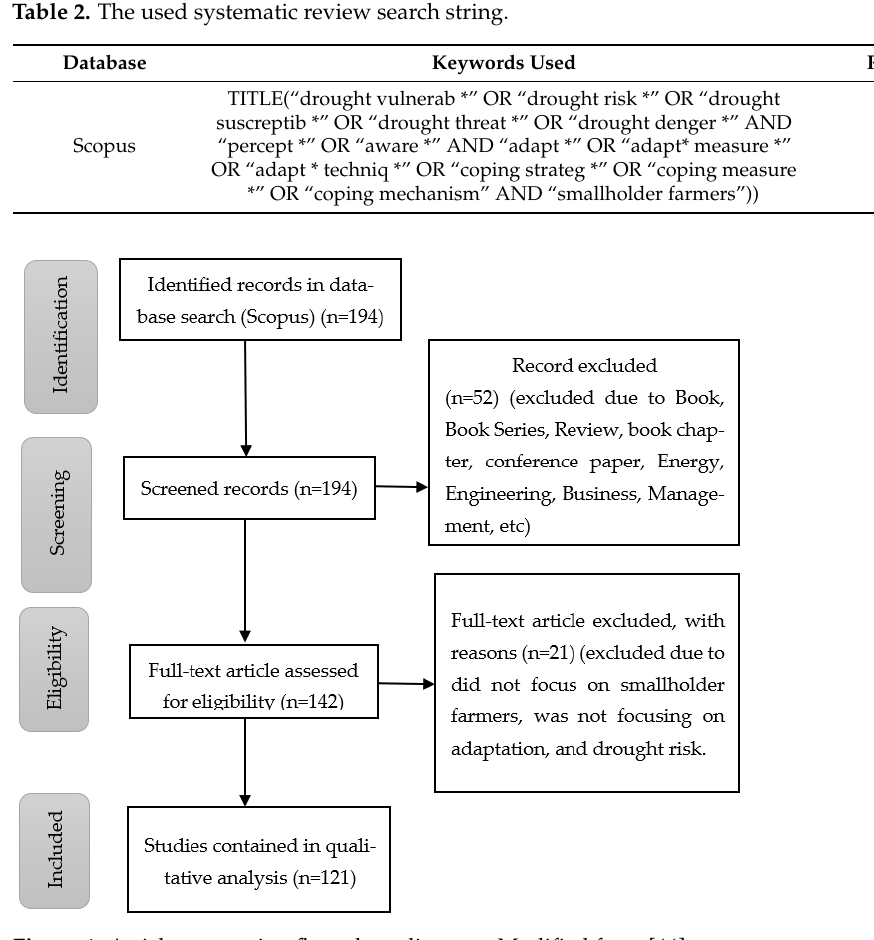
Figure 1. Articles extraction flow chart diagram. Modified from [44].